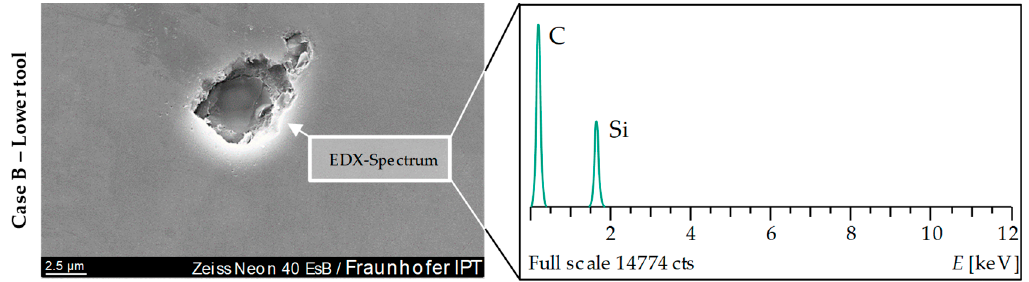
Figure 19. Fused Silica agglomeration on Glassy Carbon tool surface of Case B.